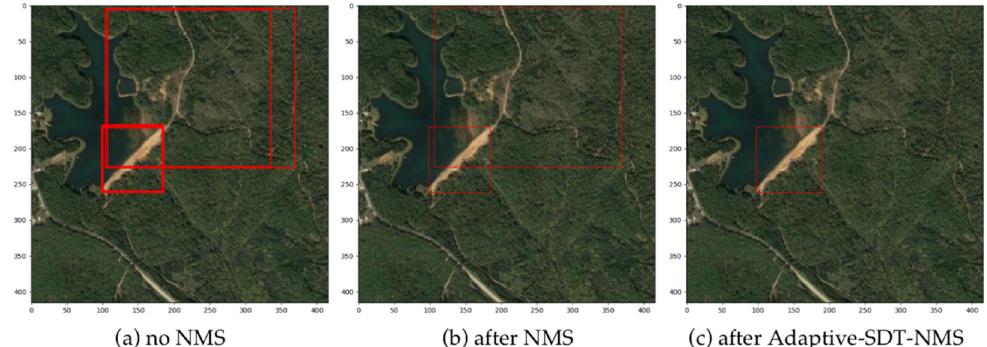
Figure 4. An example of different results for the same dam dealing with no NMS, NMS, and Adaptive-SDT-NMS algorithms. ( a ) There were 21 bounding boxes without NMS; ( b ) two bounding boxes were left, and the other redundant bounding boxes were removed by NMS; ( c ) the bounding box with the highest score was selected by our Adaptive-SDT-NMS.